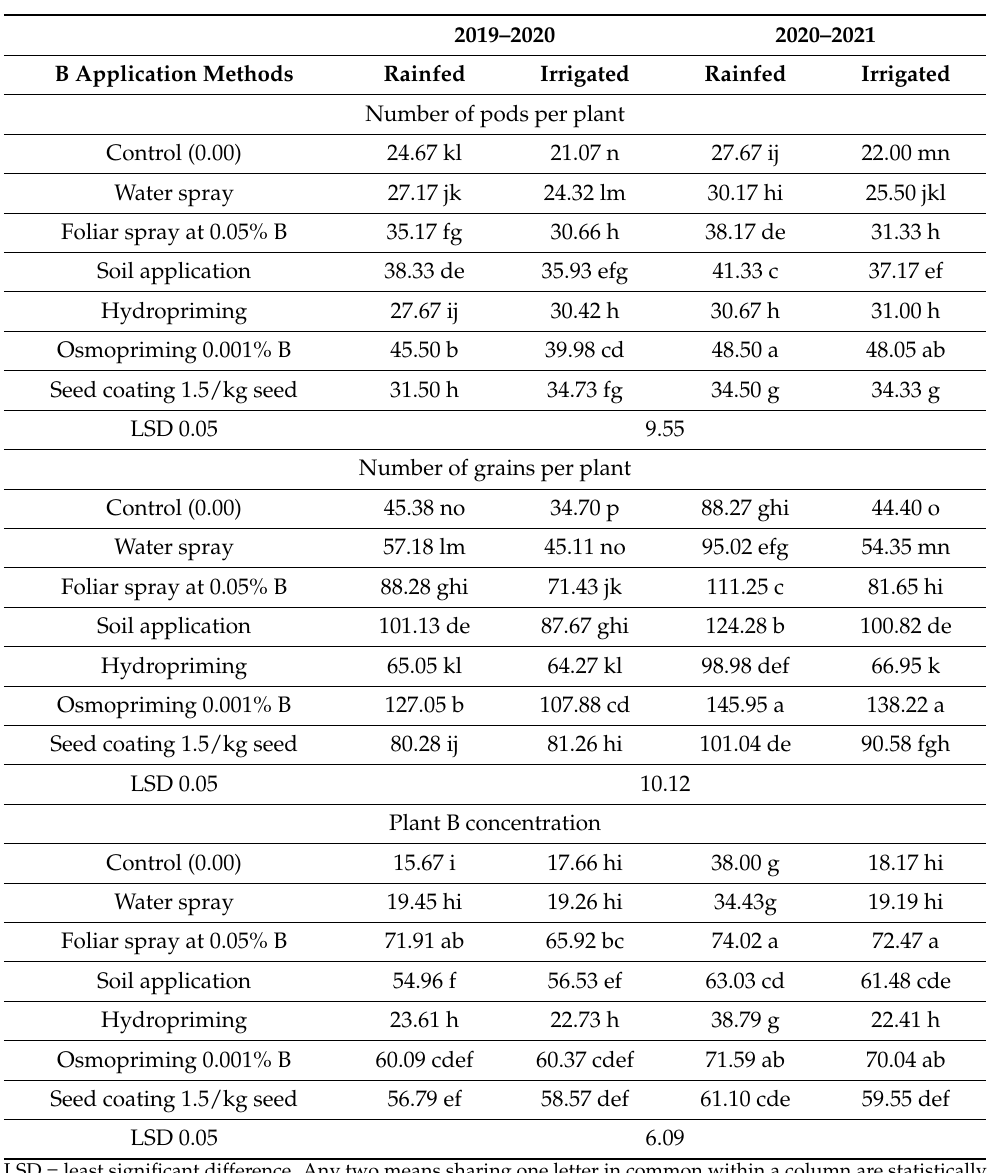
Table 6. The impact of year × location × boron application methods’ interaction on number of pods and grains per plant and plant boron concentration of desi